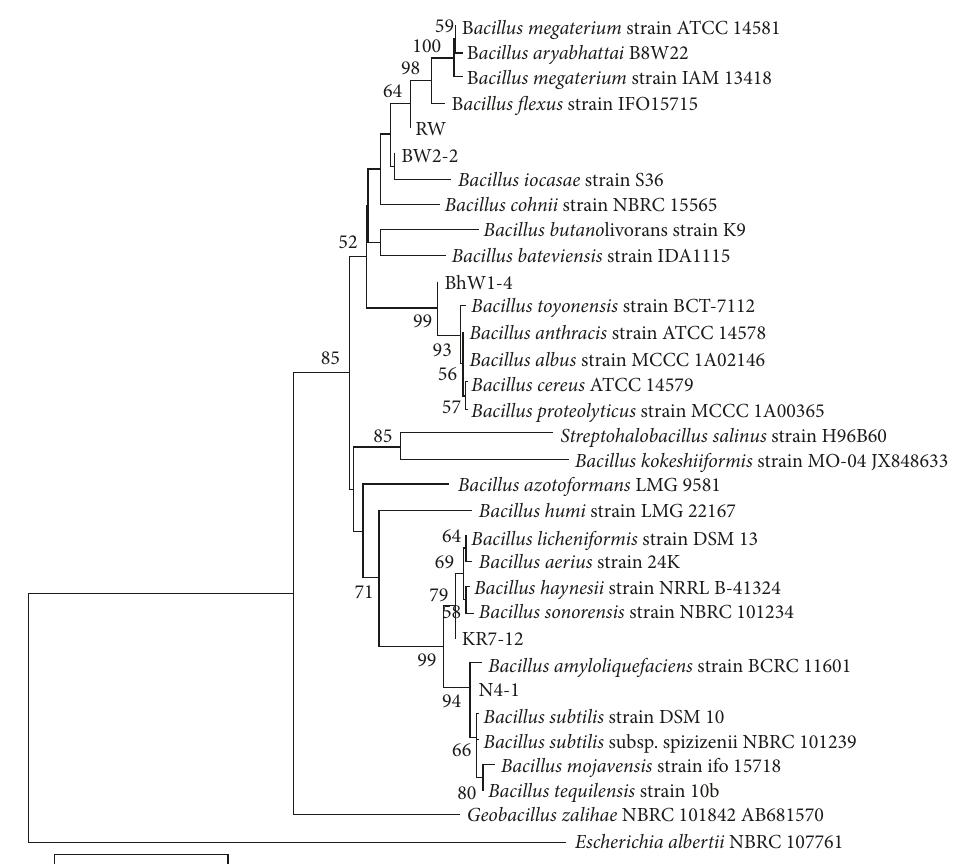
B acillus megaterium strain ATCC 14581 B acillus aryabhattai B8W22 B acillus megaterium strain IAM 13418